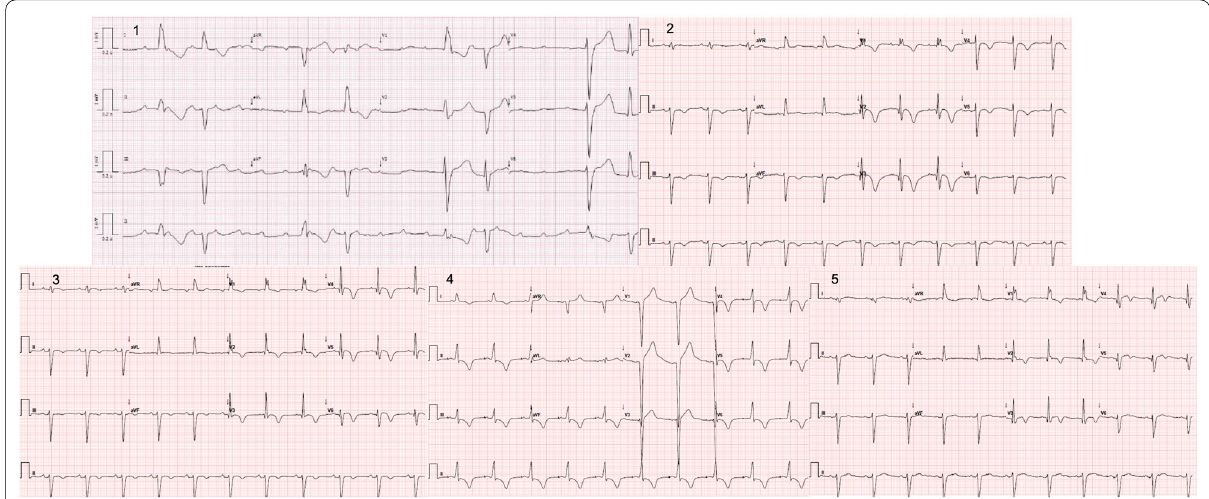
Fig. 1 ECG evolution during hospitalization—image 1 showing CHB with broad QRS complexes and T wave inversion in the inferior leads; image 2 and 3 showing sinus rhythm with left anterior fascicular block combined with complete right bundle branch block, deep T waves inversion from V1 to V6 and in the inferior leads and a prolonged QTc interval (500 ms). Image 3 after implanting dual chamber permanent pacemaker. Image 5 shows improvement in electrocardiographic changes, with QTc